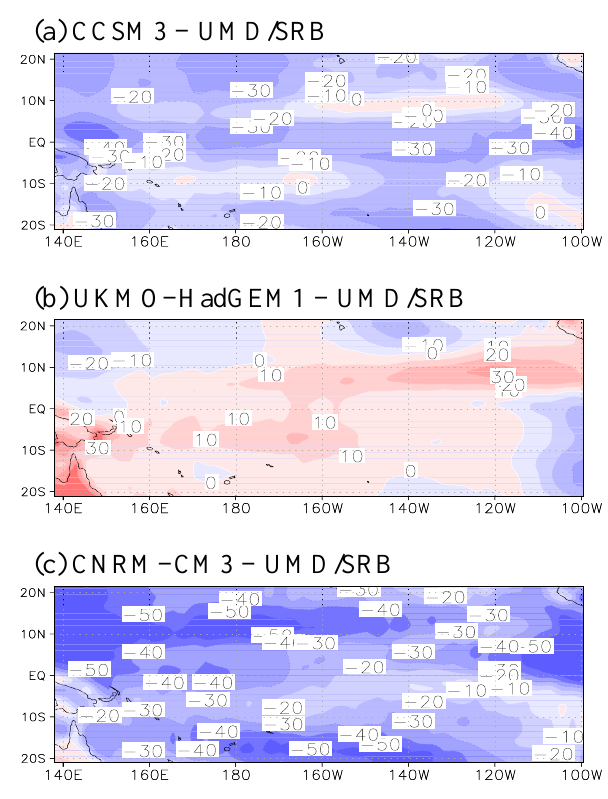
Fig. 2. Difference between SW ↓ surf from AMIP II models and the UMD/SRB estimates in Wm − 2 : (a) CCSM3; (b) UKMO- HadGEM1; (c)